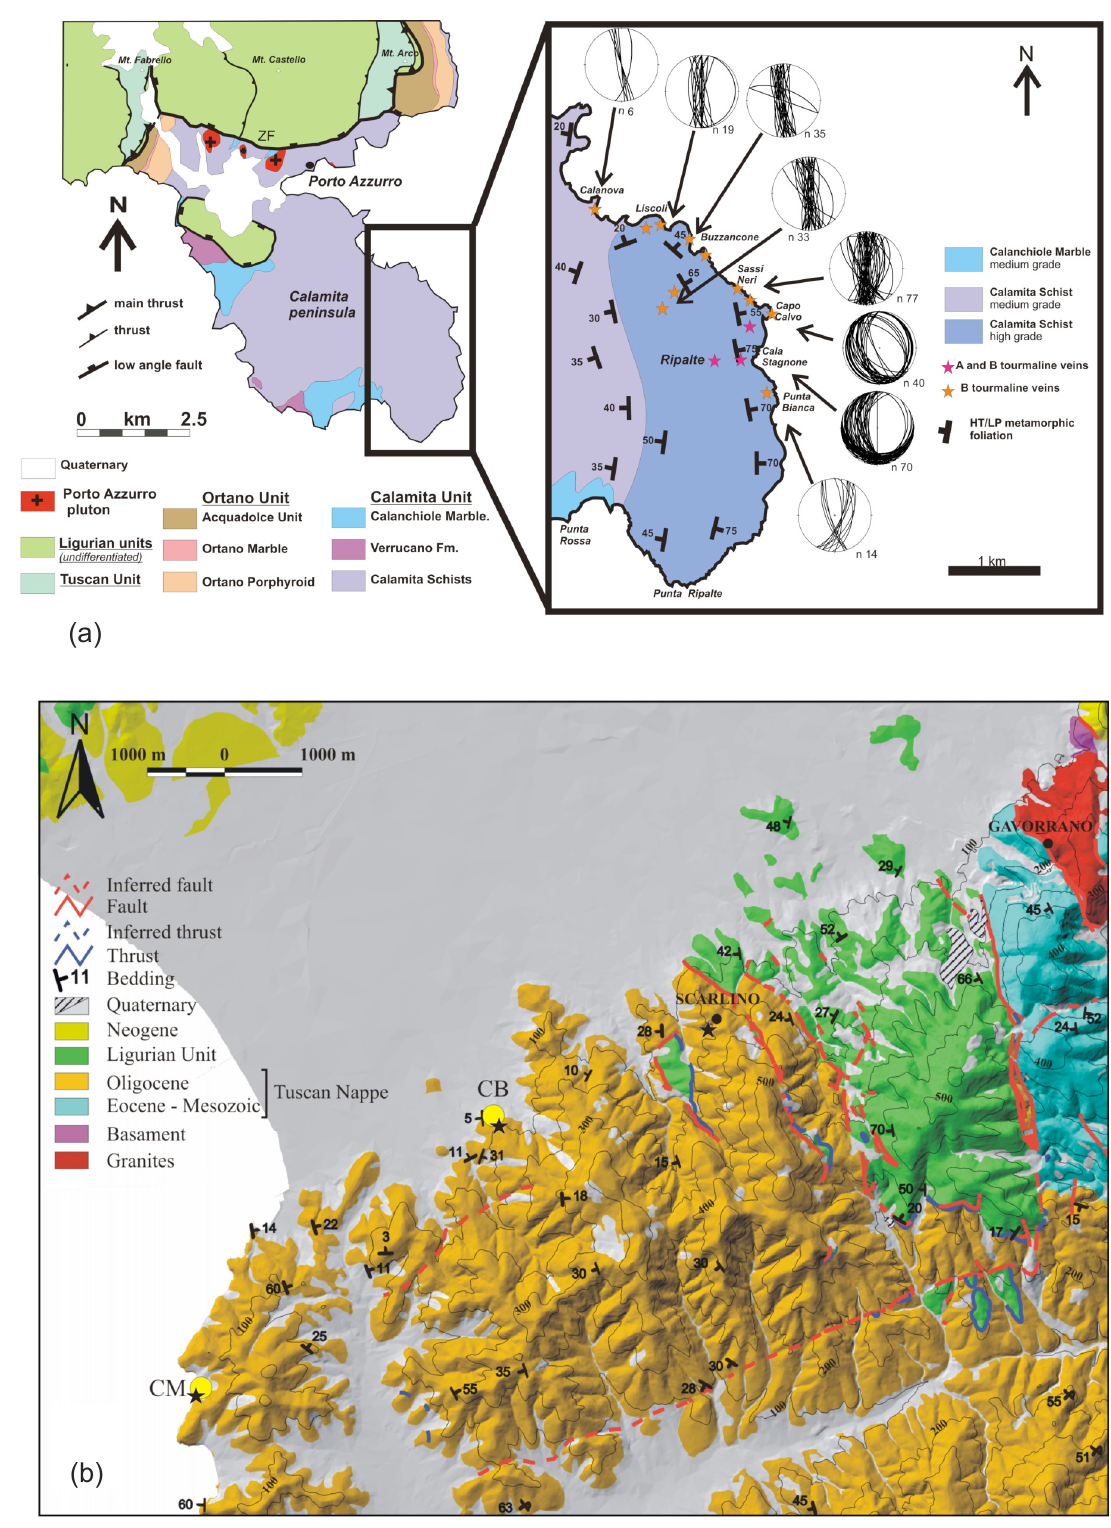
Figure 2. (a) Eastern Elba island geology and geological map of the Calamita peninsula with location of stops where tourmaline veins have been studied (after Mazzarini et al. [2011]). Lower hemisphere stereo plots of measured veins at each sites, n is the number of measured veins. (b) Scarlino area geological map with position of Cava Botrona (CB) and Cala Martina (CM) sites (after Mazzarini et al.